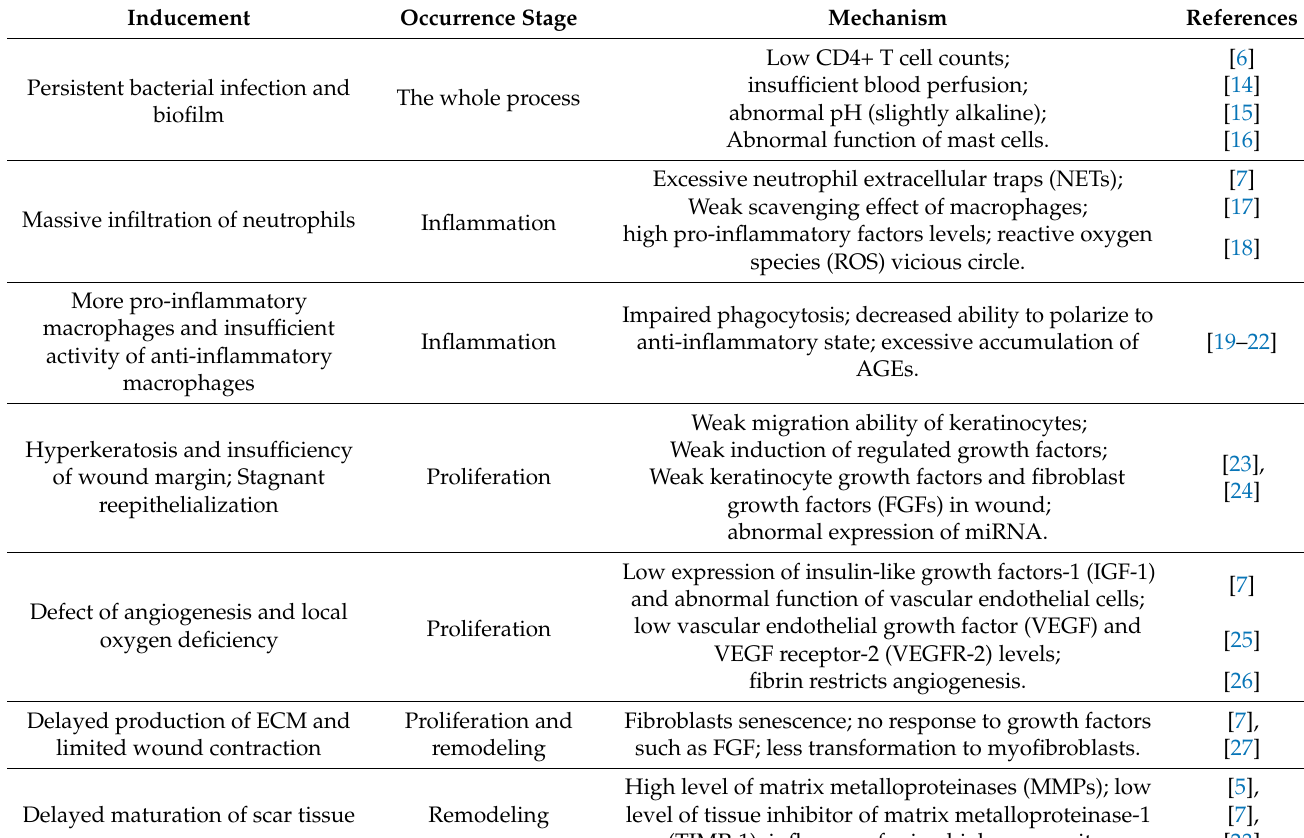
Table 1. Factors and mechanisms of action causing delayed healing of diabetic